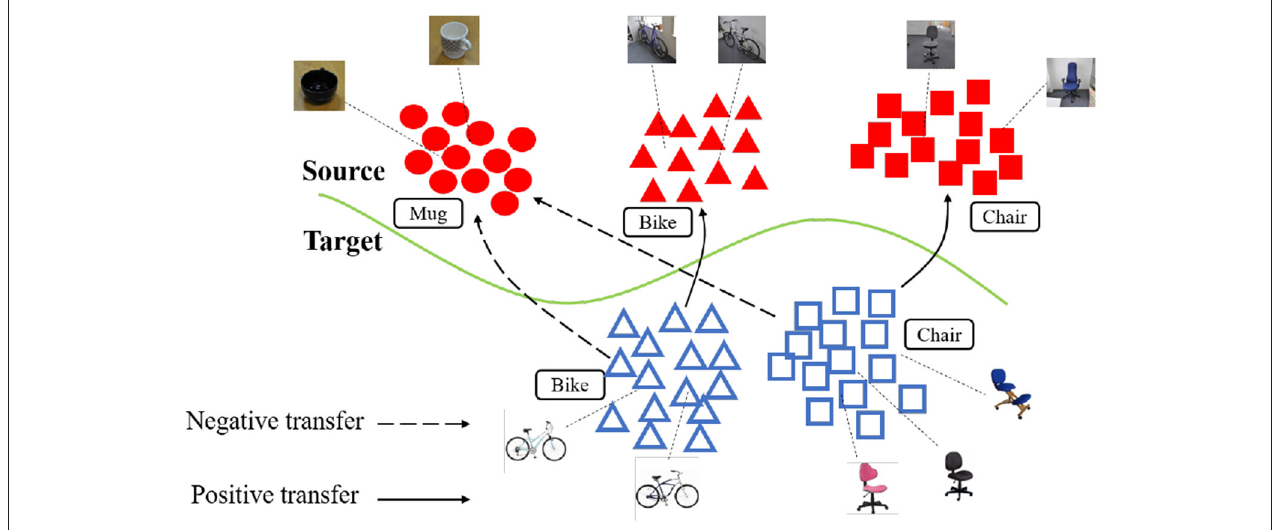
FIGURE 1 | Negative transfer in partial domain adaptation. Source and target features are colored red and blue, respectively. Target instances will be negatively transferred to source classes that are absent in the target domain (e.g., “bike” to “mug”), resulting in poorly discriminative target